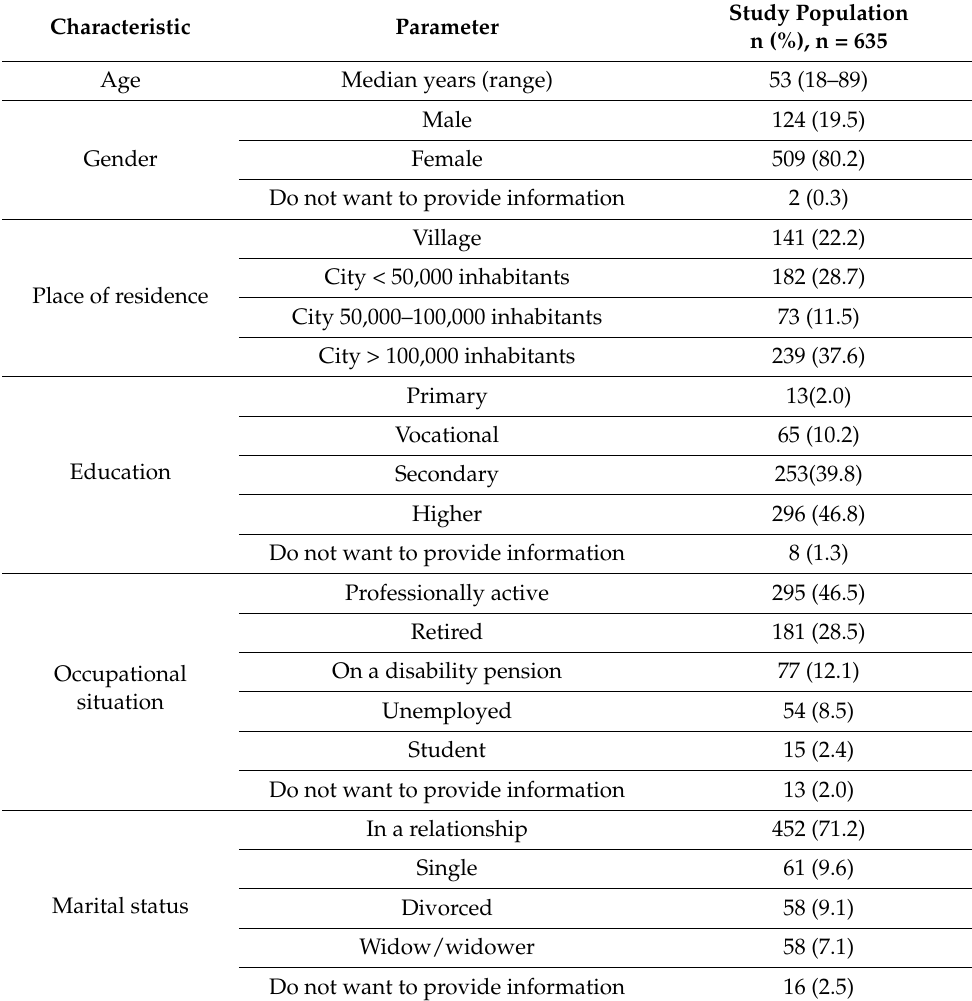
Table 1. Socio-demographic characteristics of the study